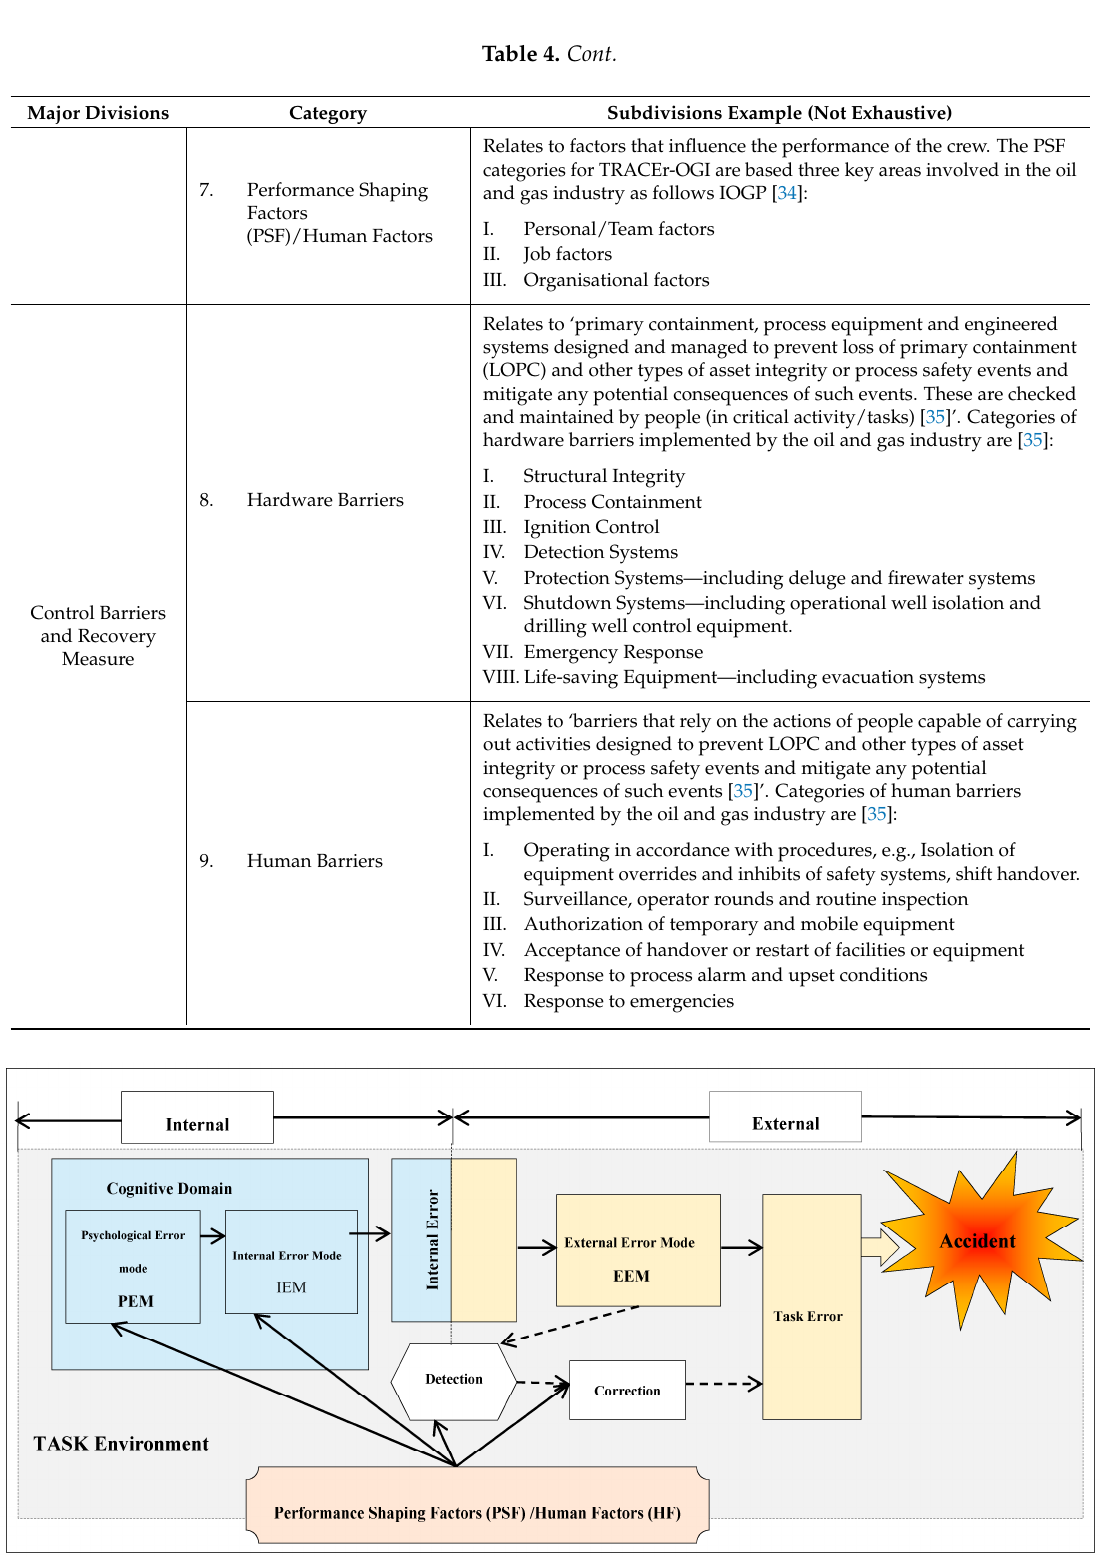
Figure 12. Relationship between TRACEr-OGI classification systems (Adapted from Shorrock Kirwan [20]).